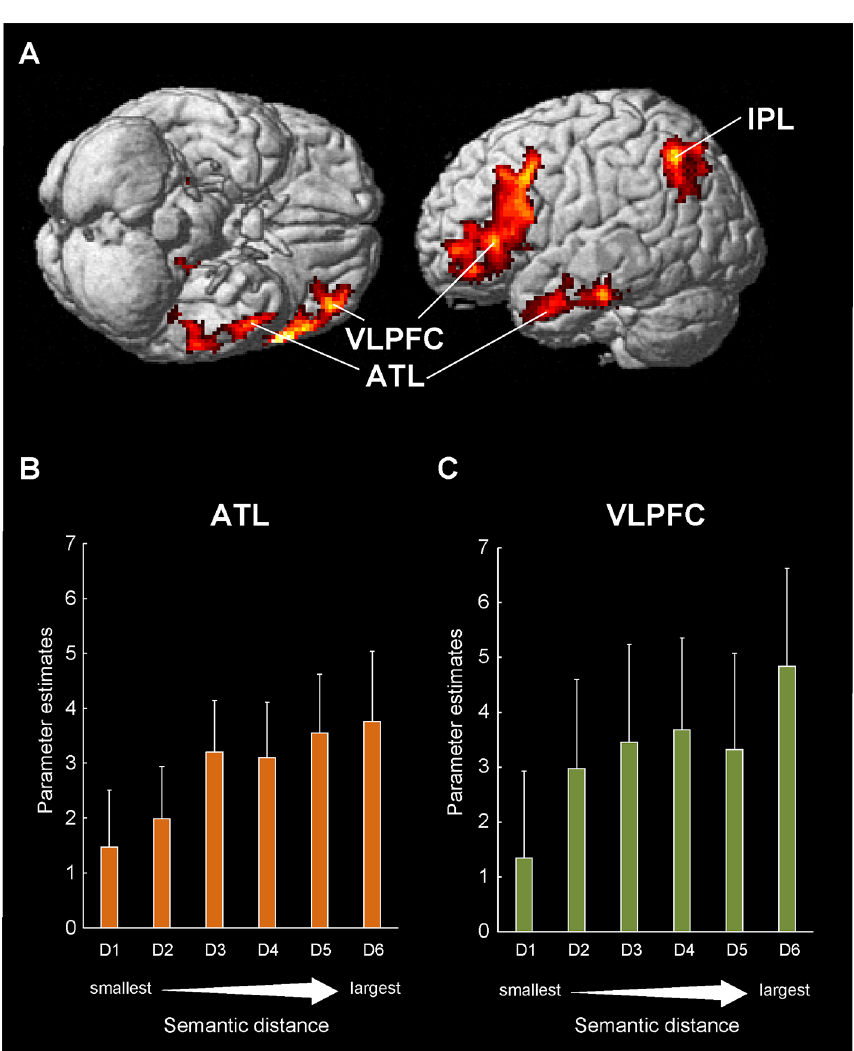
Figure 3. Decreased activation as a function of increasing semantic similarity. ( A ) four regions were detected: the left anterior temporal lobe (ATL), left ventrolateral prefrontal cortex (VLPFC), left inferior parietal lobule (IPL), and posterior cingulate cortex (PCC). All clusters are rendered on the surface of the MNI brain template. All clusters are significant at p < .05 after statistical FDR correction for multiple comparisons. ( B,C ) Semantic similarity-dependent activity of the left VLPFC and left ATL. All word pairs are divided into 6 levels (D1-D6) according to the magnitude of semantic similarity and the activations in response to each level are displayed. The activities of these regions decreased as a function of increasing semantic